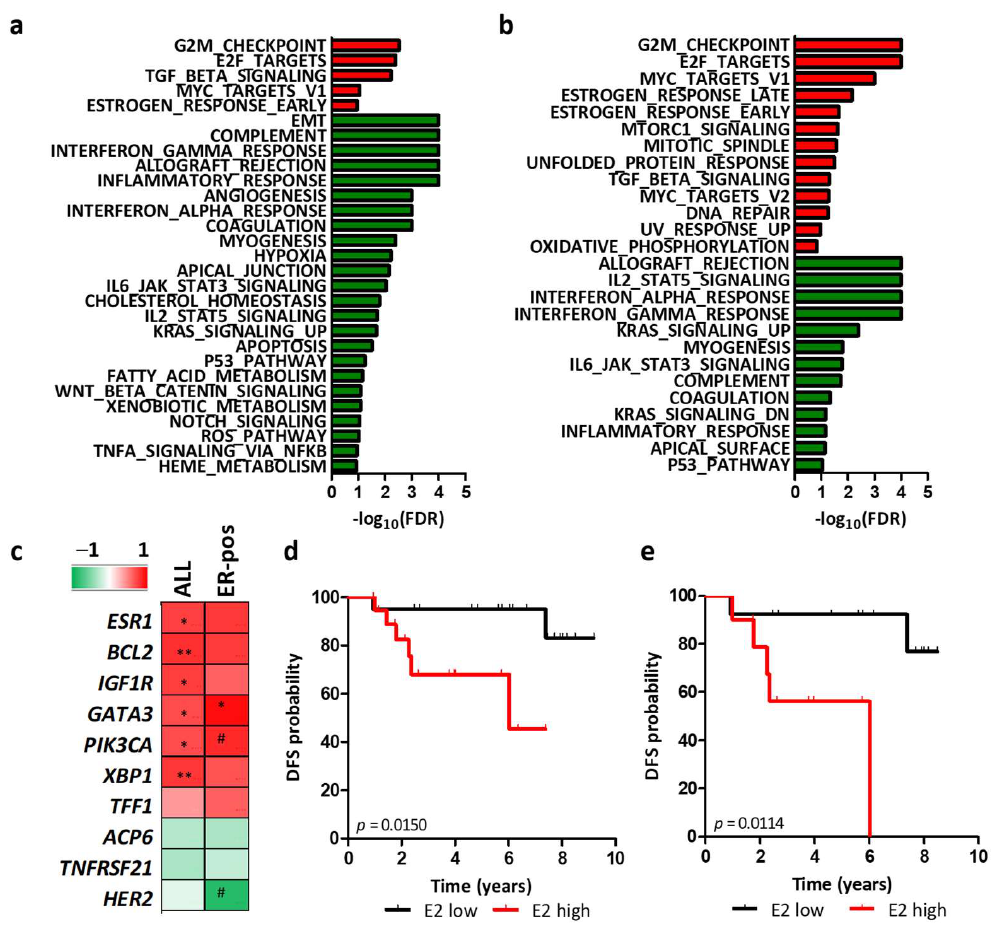
Figure 6. Correlation between E2 levels and tumor characteristics in BC patients. ( a , b ) Bar plot showing HALLMARK pathways significantly (FDR < 15%) positively (red bars) or negatively (green bars) correlated with E2 (pg/mL quantified in plasma of patients at surgery) in 10 postmenopausal HER2-positive BC patients of the GHEA cohort ( a ) and in the ER-positive subgroup (n = 5, b ) as evaluated by GSEA. FDR: false discovery rate. ( c ) Correlation of E2 with the expression of known ER-regulated genes in the same cohort analyzed in a. Pearson’s r is color-coded, and its significance is shown: # p < 0.1, * p < 0.05, ** p < 0.01. ( d , e ) Kaplan‒Meier analysis of postmenopausal patients with HER2-positive BC treated with adjuvant trastuzumab classified according to circulating E2 levels in the entire (E2 high n = 20, E2 low: n = 20, d ) and ER-positive (E2 high n = 10, E2 low: n = 13, e ) cohorts. The E2 median value in the entire cohort was used as a cutoff to define the high- and low-level groups. p values by log-rank test.